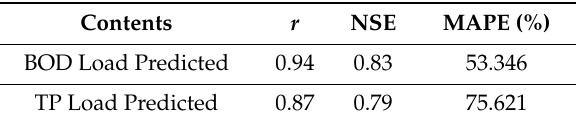
Table 5. Model evaluation